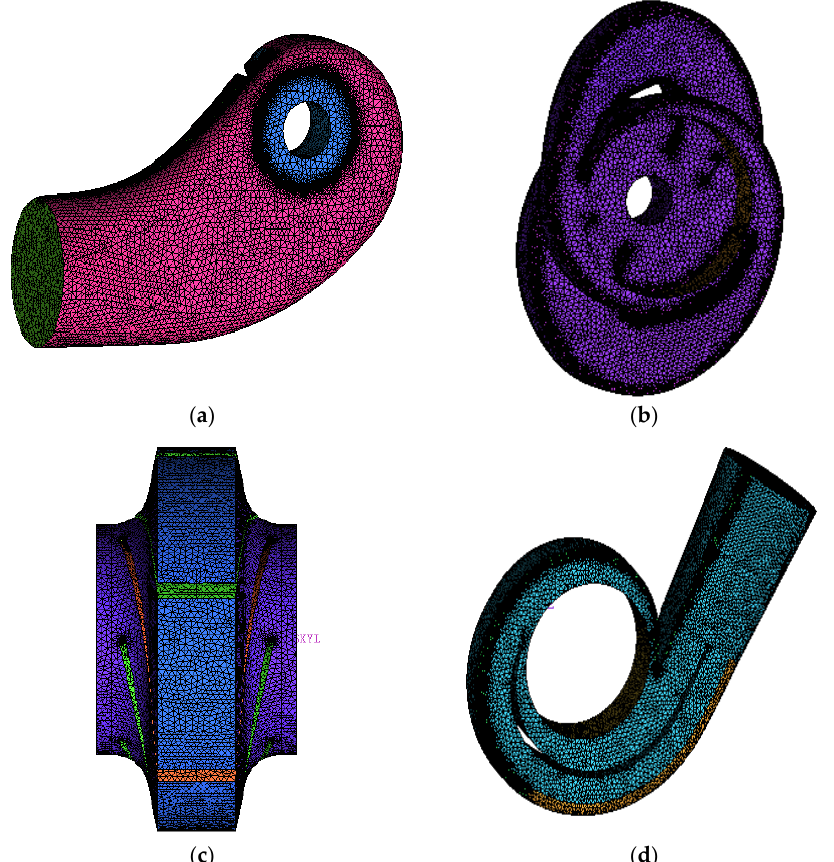
Figure 3. Flowchart of study process. ( a ) suction chamber ( b ) inter-stage flow channel ( c ) second-stage double-suction impeller ( d )